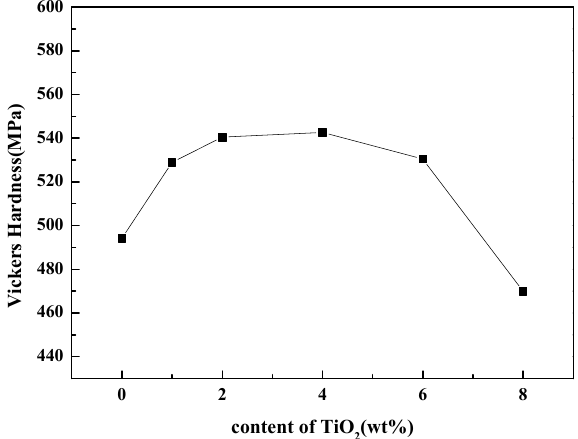
Figure 11. The Vickers hardness of the samples with di ff erent contents of TiO 2